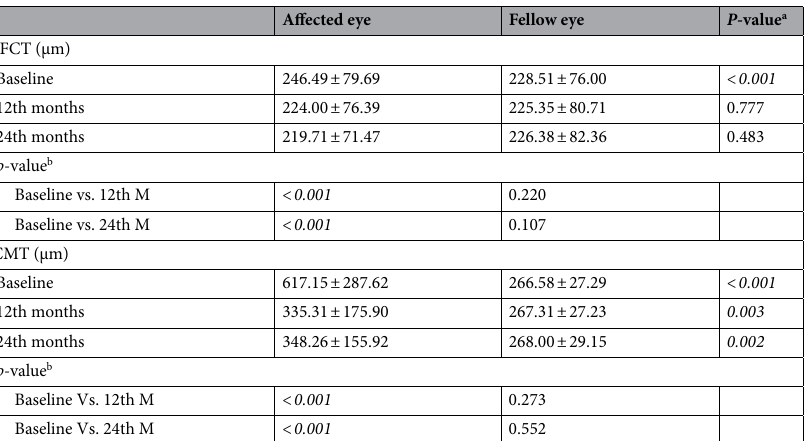
Table 3. Comparison of SFCT and CMT (μm) between the eyes in patients with CRVO (N = 41, 41 eyes). Values are presented as the mean ± standard deviation, unless otherwise indicated. SFCT subfoveal choroidal thickness, CRVO Central retinal vein occlusion. a Comparison between affected and fellow eyes in each period. p -value derived from the paired two-tailed t-test. b Comparison between baseline and follow-up for each value. p- value derived from the paired two-tailed t-test. Significant values are in italics.